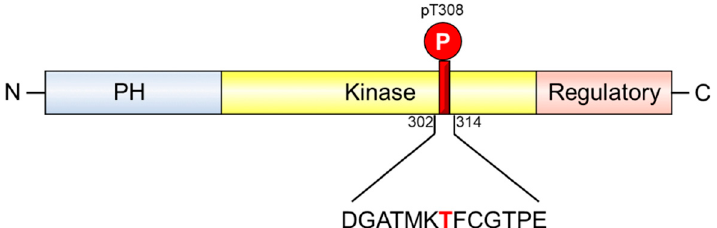
Figure 1. Primary structure of the Akt1 protein. The kinase consists of an N-terminal pleckstrin homology (PH) domain (blue), a serine/threonine kinase catalytic domain (yellow), and a C-terminal regulatory domain (pink). The amino acid sequence from residues 301 to 314, including pT308, was used in peptide form for affinity selection experiments.